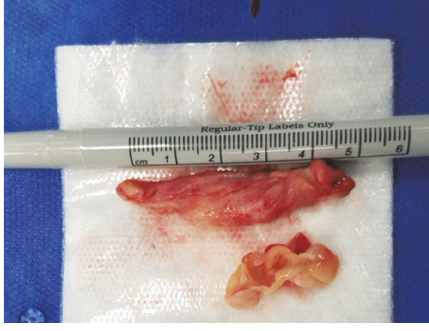
Figure 2: Gross specimen of polyp from case #1.